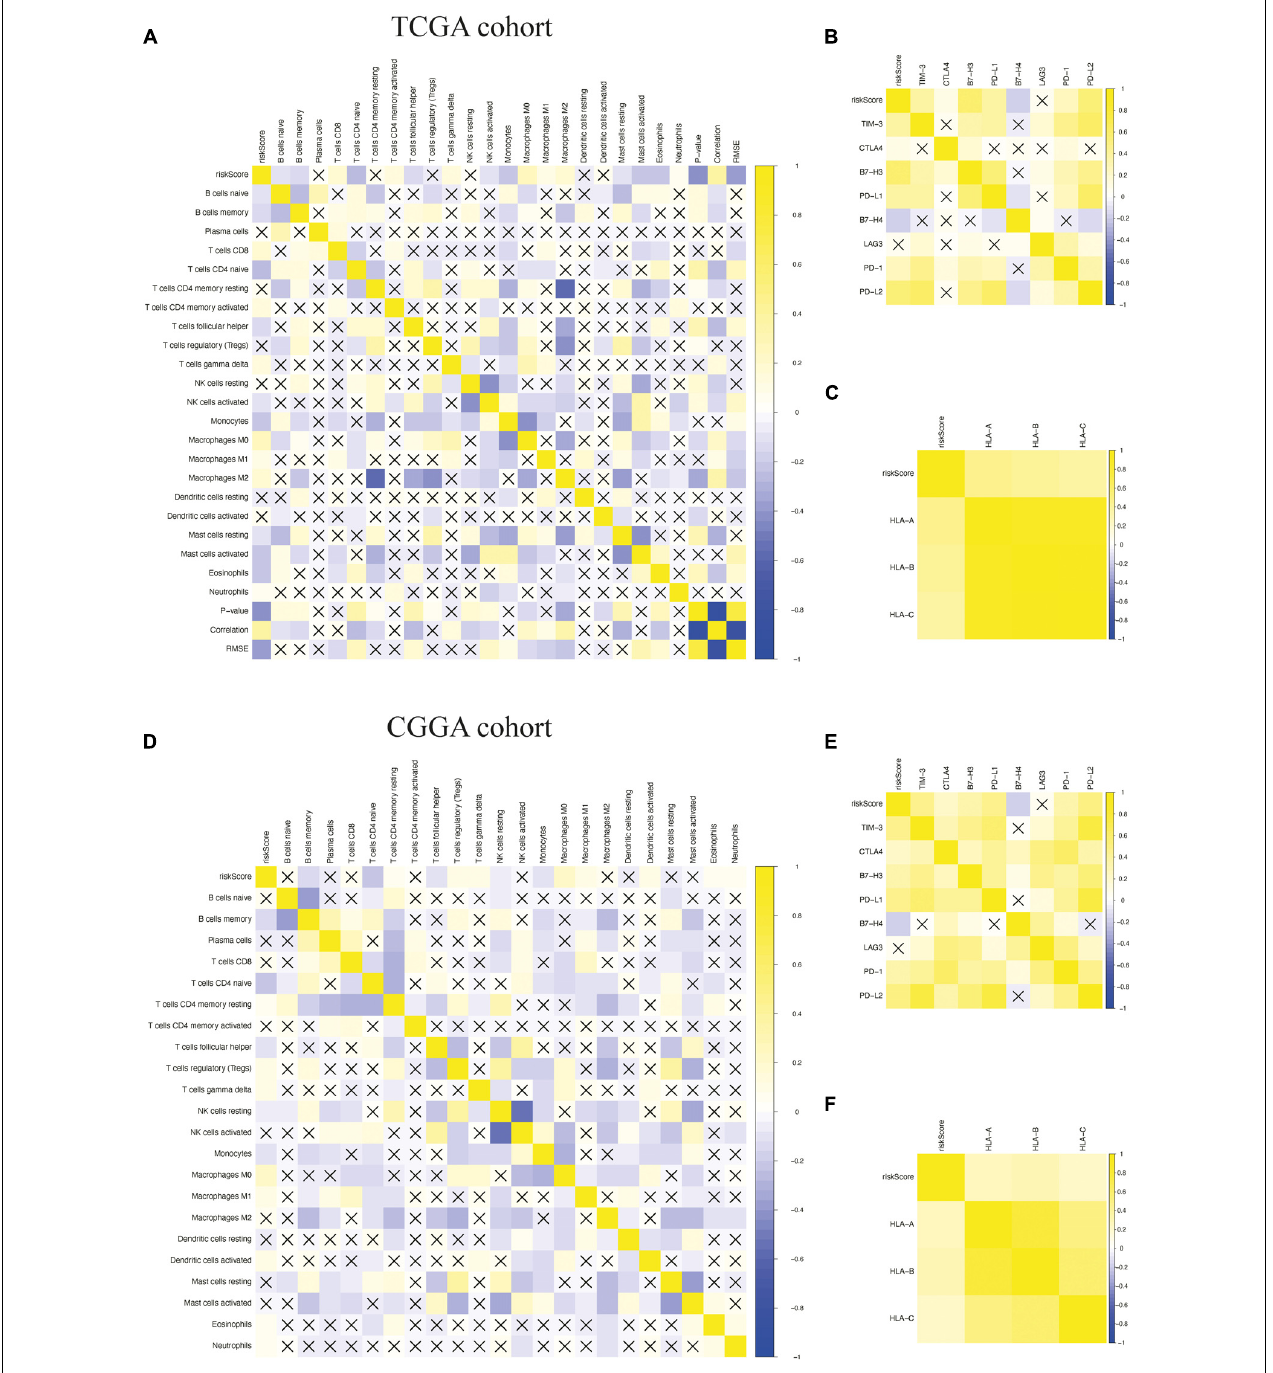
FIGURE 9 | Pearson correlation analysis between the risk score and immune cell infiltration, immune checkpoints, and human leukocyte antigen (HLA) complex expressions. (A–C) Pearson correlation analysis between the risk score and the level of immune cell infiltration, the expressions of immune checkpoints, and the expressions of HLA complex in The Cancer Genome Atlas (TCGA) cohort. (D–F) Pearson correlation analysis between the risk score and the level of immune cell infiltration, the expressions of immune checkpoints, and the expressions of HLA complex in the Chinese Glioma Genome Atlas (CGGA) cohort. “X” means P > 0.05.